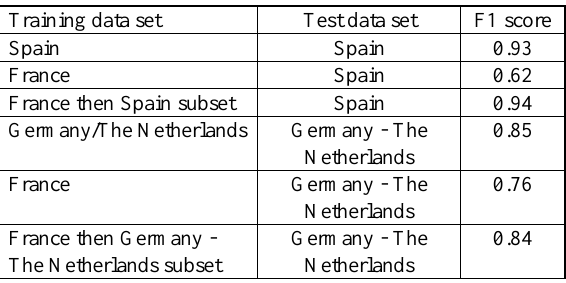
Table 3 . Transfer learning results.